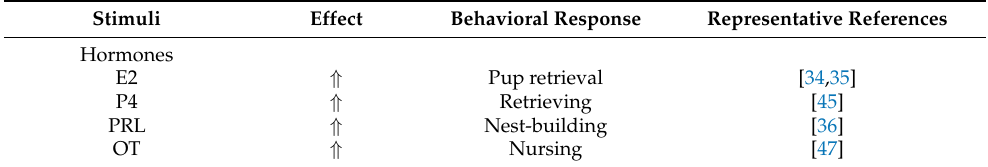
Table 2. Natural stimuli that trigger maternal behavior. Estrogen (E2), progesterone (P4),